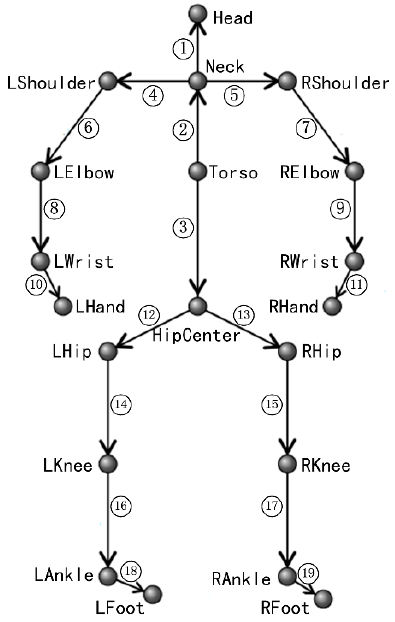
Figure 2. The NRO features based on human skeleton.